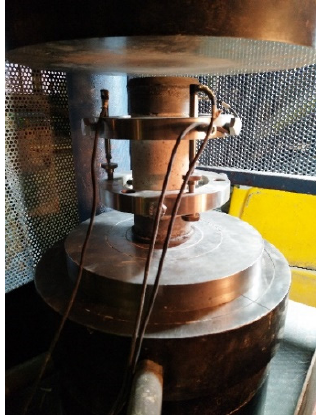
Figure 4. Photos of mechanical performance tests.